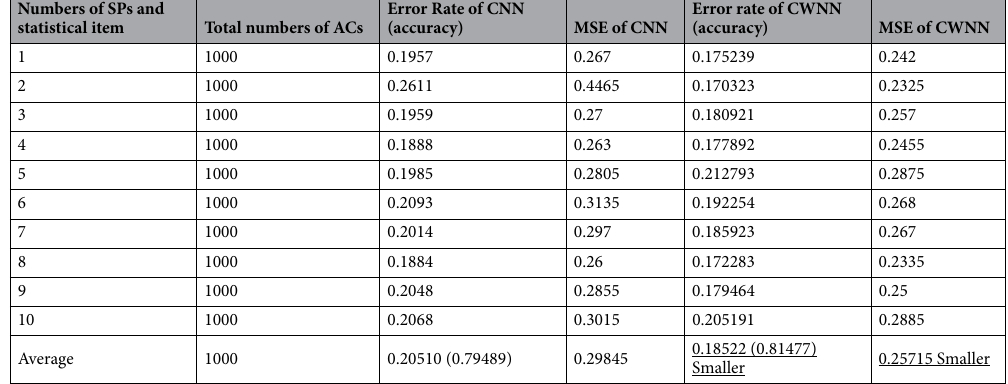
Table 4. Simulation results of CNN and CWNN on CIFAR-10. Underlined values represent the results with the highest accuracy or the lowest mean square error. Numbers of SPs and statistical